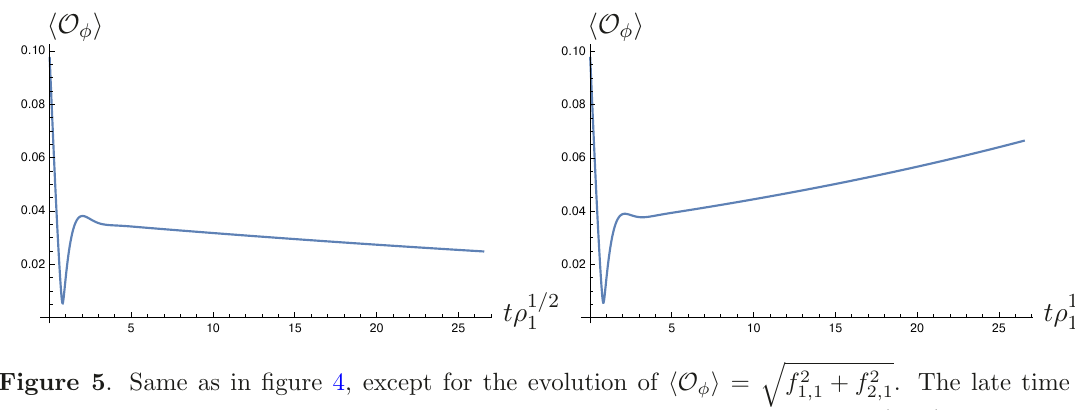
ω I, fit to compare with the QNM behaviour, see (2.46). ≡